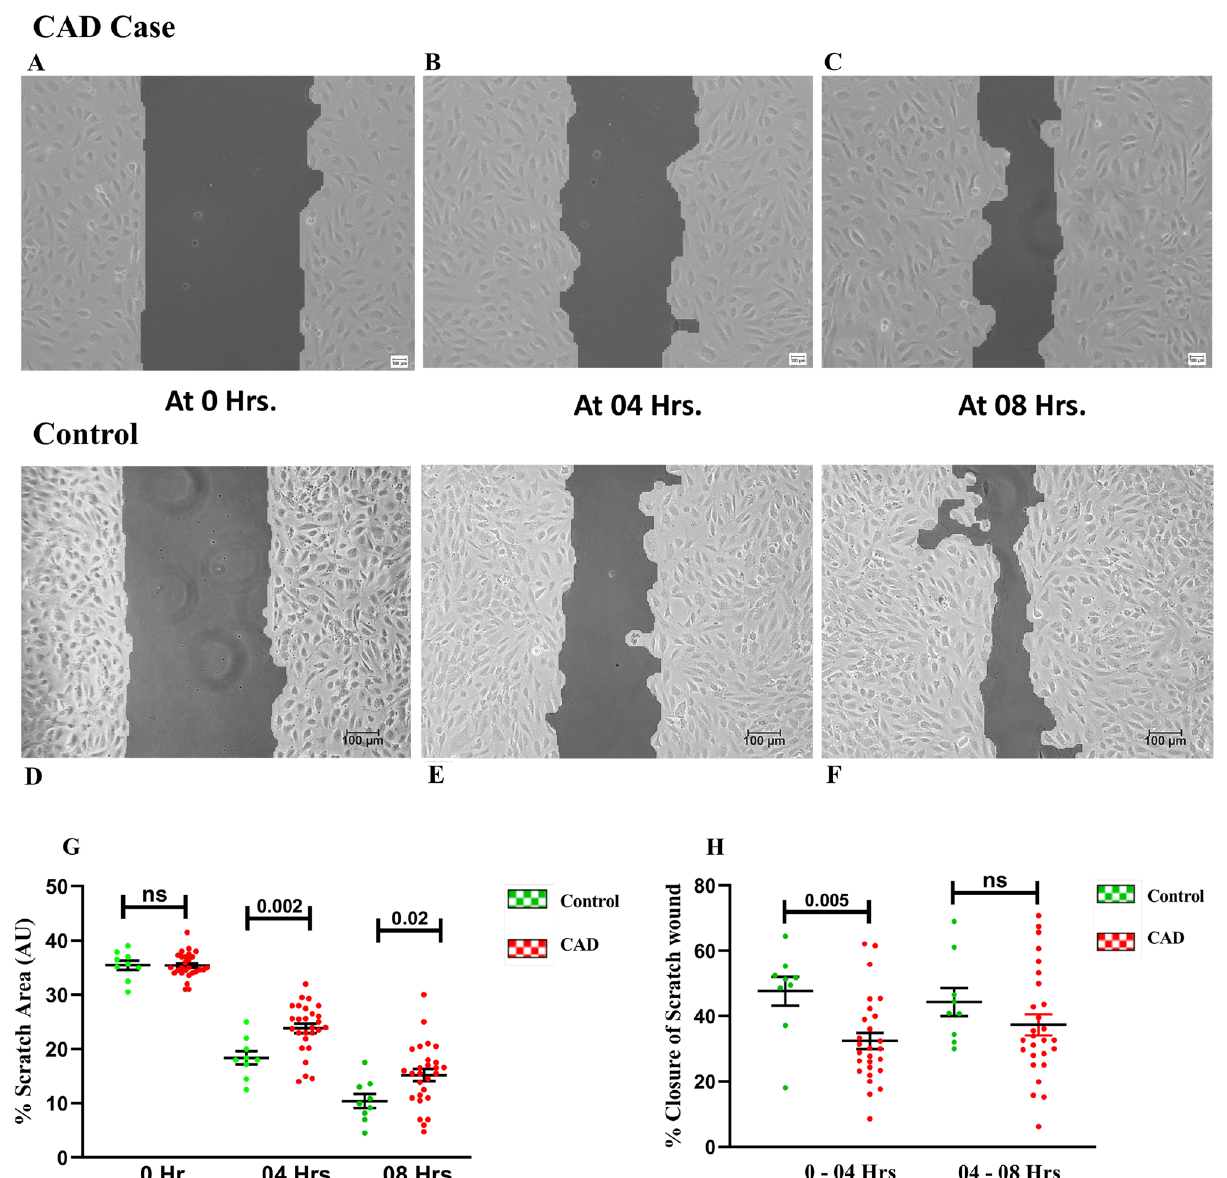
Figure 7. In vitro scratch wound assay by ECFCs at different time points in CAD and healthy controls. Bright field phase contrast microscopic images (10x) of in vitro scratch wound assay at different time points (0 h, 04 h and 08 h) is depicted in ( A – F) . ( A – C) shows 10 × image of wound closure that is 0 h, 4 h and 8 h in CAD patients (n = 27); ( D – F) shows wound closure at three different time points that is 0 h, 04 h and 08 h in control subjects ( D – F ) (n = 09); Scale bar 100 µm; G shows histogram depicting % scratch wound area between the two-cell monolayer at three time points (0 h, at 04 h and at 08 h), (n = 27 for CAD and 9 for controls). ( H) shows % in vitro scratch wound closure by ECFCs at two different time points from 0 to 04 h and 04 to 08 h in CAD (n = 27) and control (n = 9) groups ( H ). Student ttest was used to assess the significance difference. Data is represented as mean ± SE. Error bar represent standard error of mean; dots represent average values of the parameters obtained from experimental duplicates; p ≤ 0.05 considered statistically significant eNOS uncoupling is one of the source of systemic level of oxidative stress which was explained by high plasma lipoperoxidation levels in monosodium glutamate (MSG) induced obese rats compared to control and treatment with eNOS inhibitor N G -nitro-L-arginine methyl ester (L-NAME) was able to reduce the systemic lipoperoxida- tion levels in both obese rats as well as controls 24 . Similar to our observation of a reduced BH4 levels, its possible effect on eNOS catalytic activity and consequent effect on ECFC proliferative capacity, migration capacity and angiogenesis potential with SIN-1 treatment, Yu Dong et al . reported a decline in phosphorylation of eNOS and in vitro tube formation by EPCs in SIN-1 treated group 15 . We also observed a reduced BH2 levels with SIN-1 treatment which possibly reflects impaired BH4 biosynthesis. Both oxidative loss of BH4 and reduced biosyn- thesis of BH4 may be acting to determine intracellular biopterin levels.